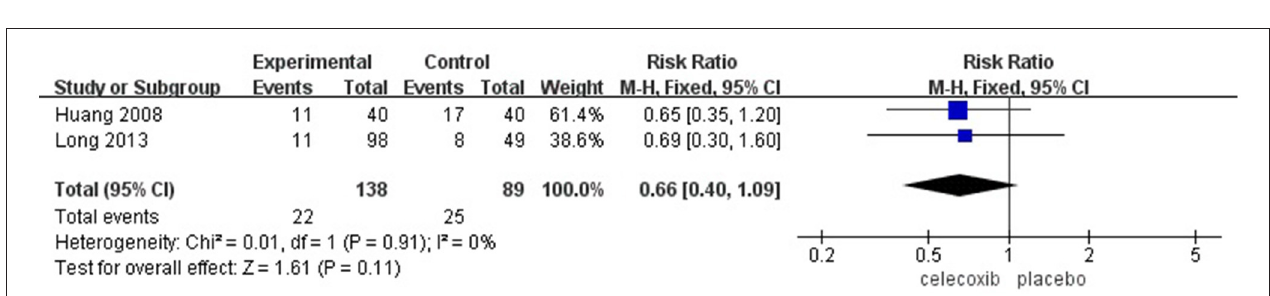
FIGURE 5 | Forest plot for the meta-analysis of active ROM at postoperative (A) 24h, (B) 48h, (C) 72h, and (D) 7 days.